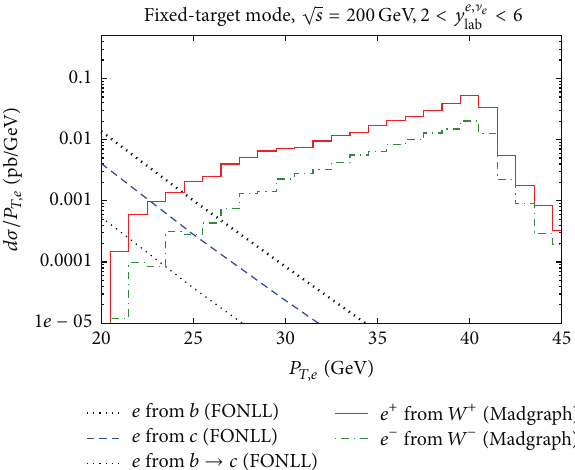
Figure 3: 𝑃 𝑇 spectra for heavy-flavour-decay electrons (and positrons) as predicted by FONLL compared to that from the predicted signal from 𝑊 ± decays obtained with Madgraph 4 [29] at √𝑠 = 200 GeV. The FONLL cross sections have been evaluated with the default setup of http://www.lpthe.jussieu.fr/ ∼ cacciari/fonll/fonll- form.html along the lines of [30–32] with the PDFs CTEQ6.6M